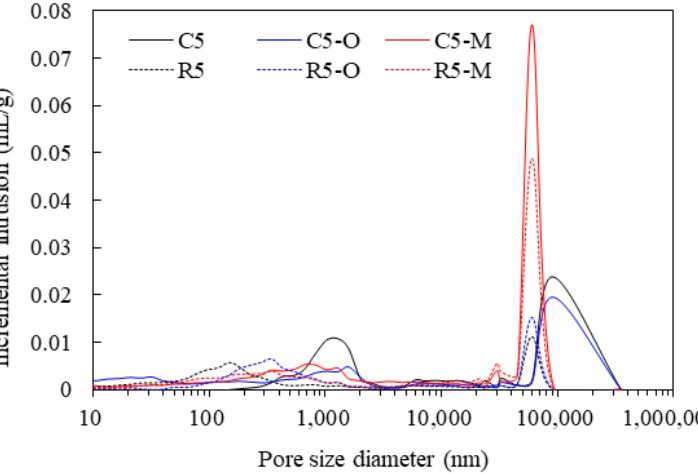
Figure 7. Pore size distribution of the cement mortar mixed with water repellents.